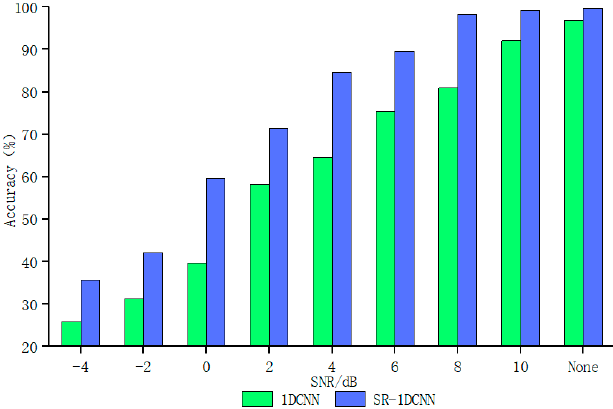
Figure 17. Accuracy of ten experiments.